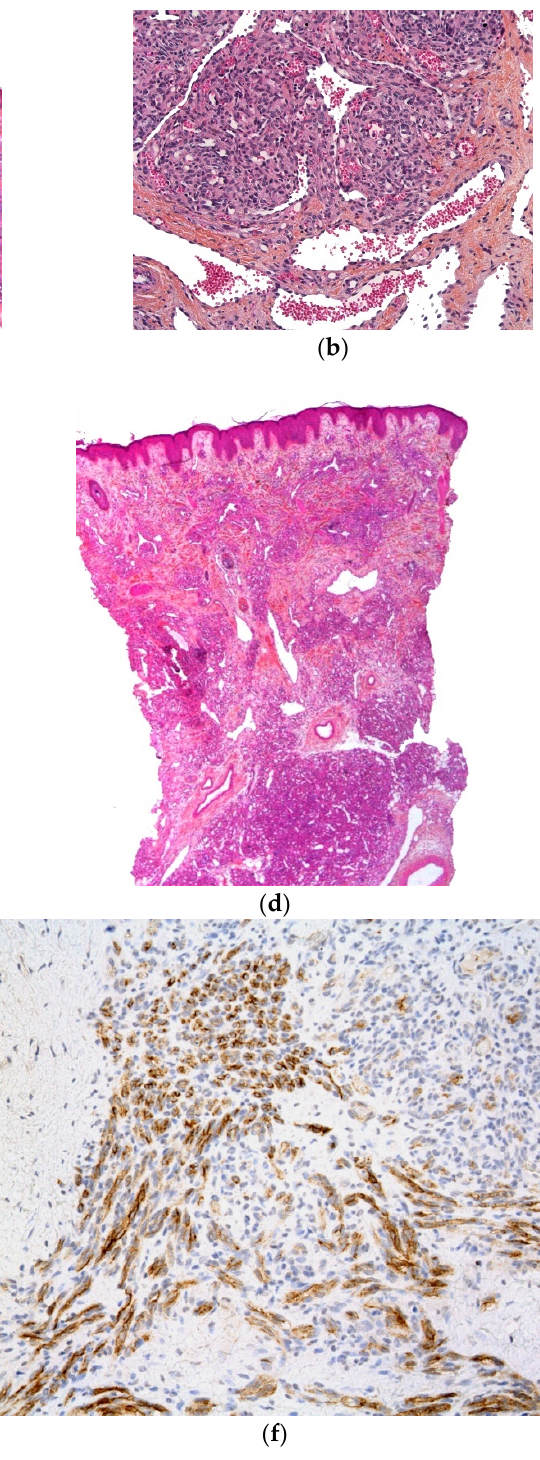
Figure 15. Tufted angioma and kaposiform hemangioendotheliomatosis. ( a ) 25× numerous very small and well-limited lobules throughout the dermis. ( b ) 25× packed small vessels and crescent-shaped vascular channel surrounding it. ( c ) Anti- podoplanin staining the lobules partially. ( d ) Poorly limited and infiltrative vascular tumor in the dermis extending into the subcutis. ( e ) Spindle-shaped cells with red blood cells in between. ( f ) Partial staining of the vessels with anti- podoplanin.